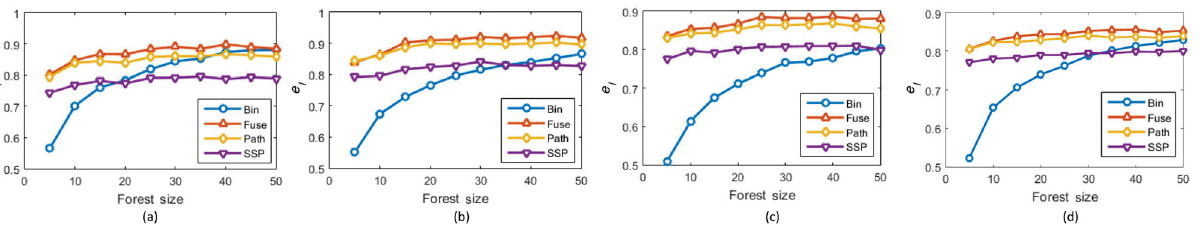
Fig. 5 Dice similarity e I of nearest-neighbors obtained by the combined forest-based metric (Fuse), the binary metric (Bin), the common- path-based metric (Path), and the SSP-based metrics for four toy datasets: (a) corner , (b) puncturedsphere , (c) twinpeaks , and (d) 3 D clusters